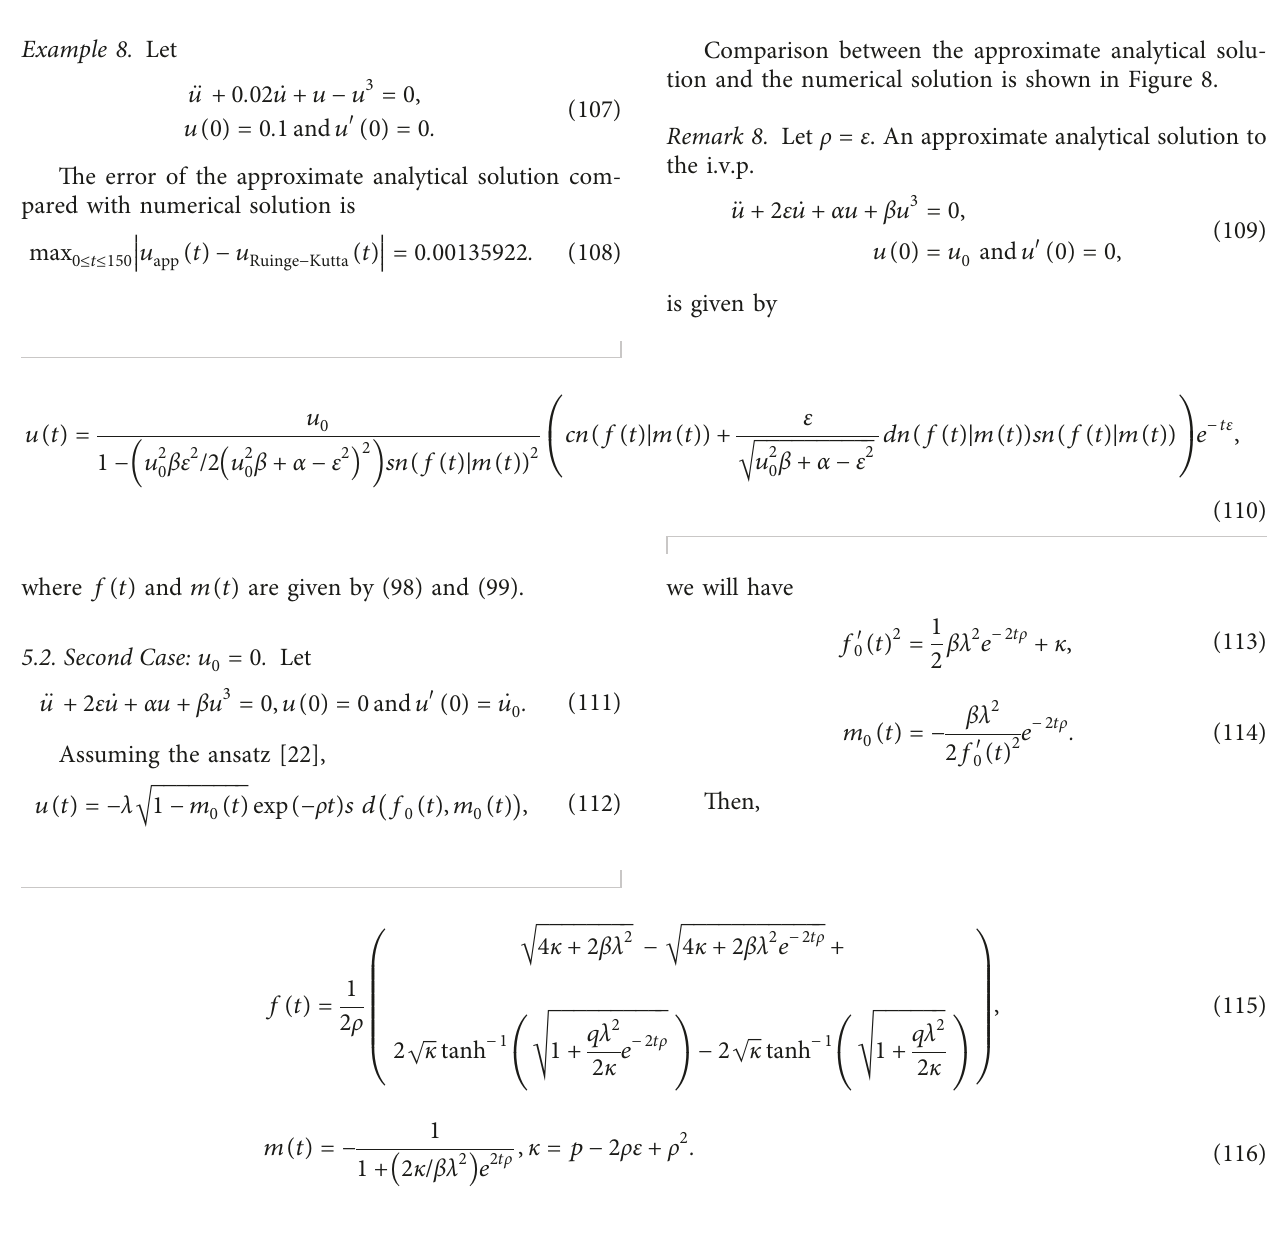
Figure 8: Comparison between the approximate analytical solution and the numerical solution for Example